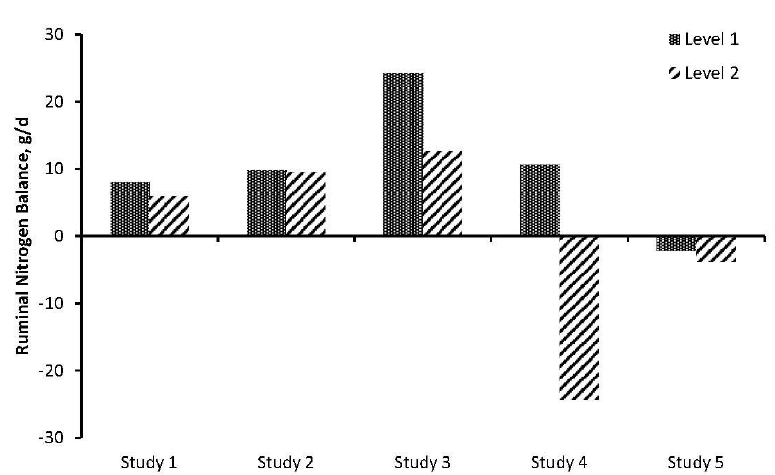
Figure 2. Model-predicted ruminal nitrogen balance using level 1 (dotted bars) or level 2 (hashed bars) solutions of the Large Ruminant Nutrition System for each study, averaged across treatments.